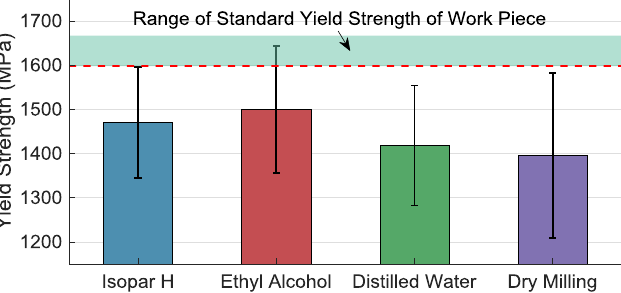
Figure 8. Yield stress of work piece micromilled under different coolants and methods.